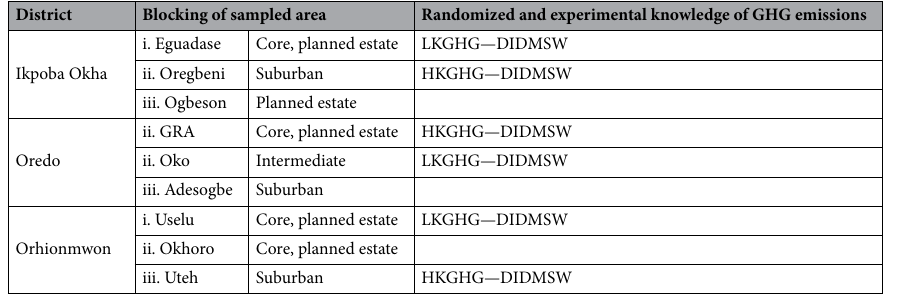
Table 4. Randomized block design of the study area. Extrapolated from Fig. 6 in which inference was made on the knowledge of GHG emissions and MSW based on socioeconomic characteristics of residents from different residential areas. LKGHG—DIDMSW: Low knowledge of GHG emissions and danger of indiscriminate dumping of MSW, HKGHG—DIDMSW: High knowledge of GHG emissions and danger of indiscriminate dumping of